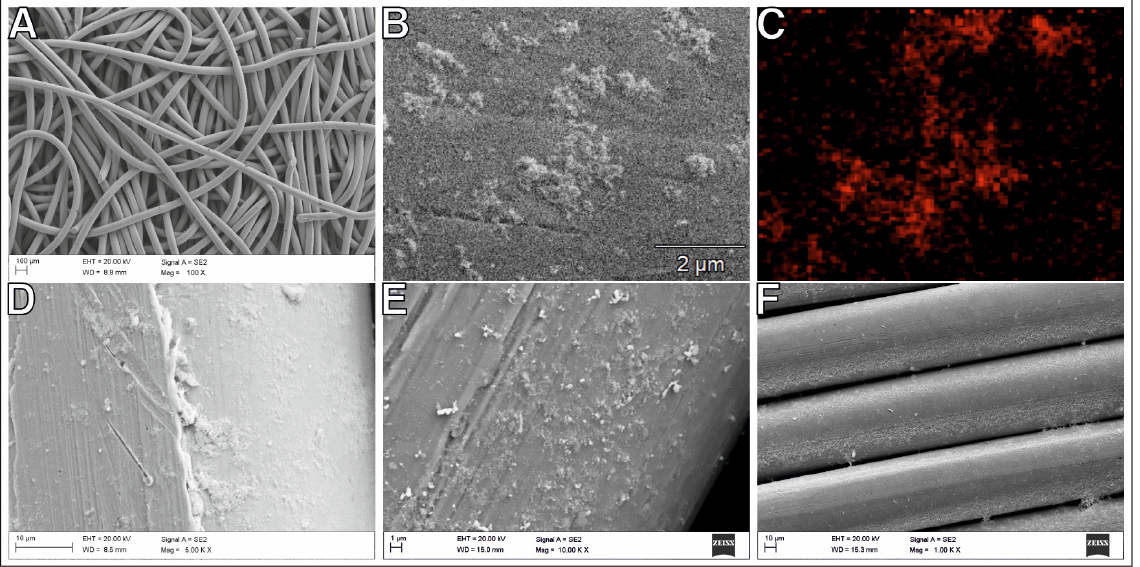
Figure 3. Scanning electron microscopy (SEM) images for nanometal/Ni-mesh catalysts, ( A ) Ni- mesh support fibers with Ru nanoparticles, ( B ) Re nanoparticles on the fibers surface, ( C ) Pd nano- particles on the fiber surface, ( D ) Au nanoparticles on the surface of the fibers in contact. Table 1. Specific surface area (SSA) for the tested supports. No